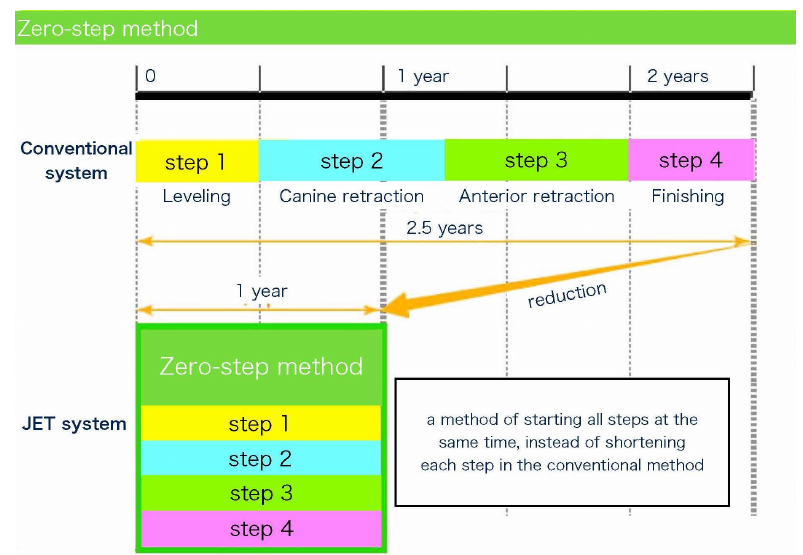
Figure 1. Comparison of conventional orthodontic treatment with the Jiyugaoka Enjoyable Treat- ment (JET) system. (JET)